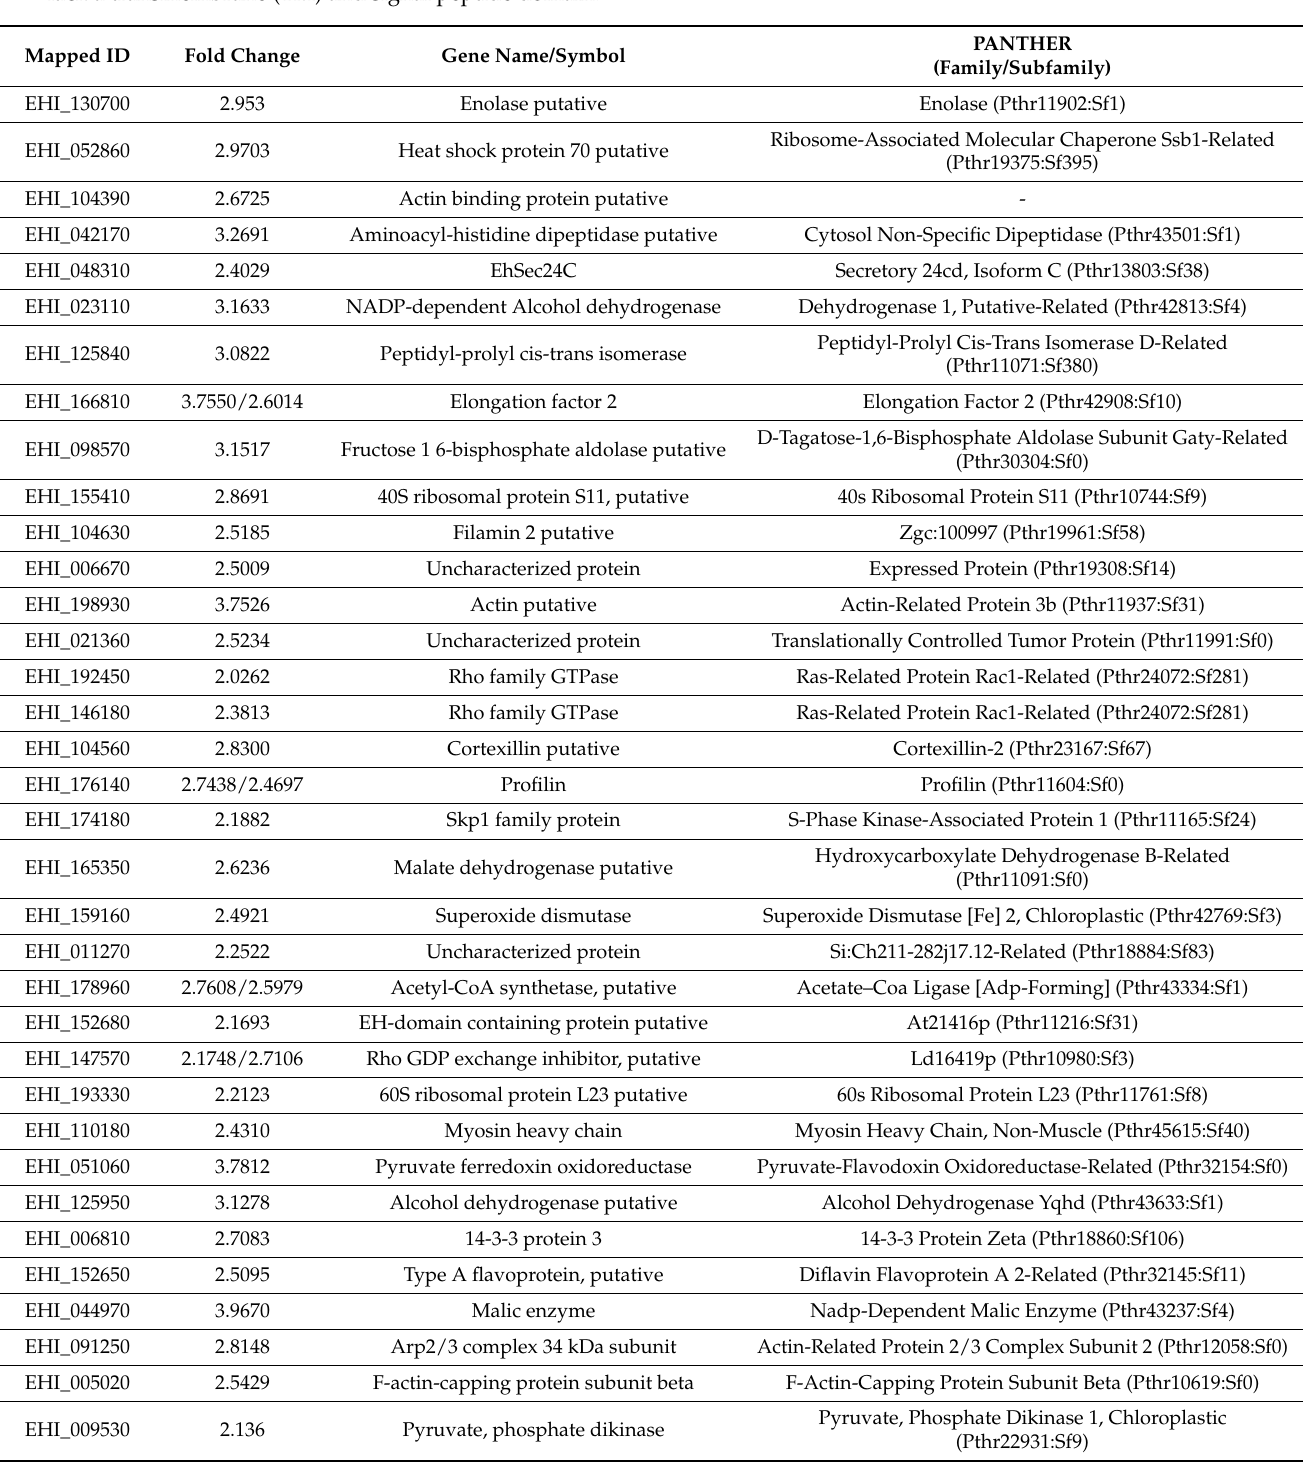
Table 3. Decreased abundance of cytosolic proteins in the membrane versus cytosolic fractions (q < 0.05). These proteins lack a transmembrane (TM) and signal peptide